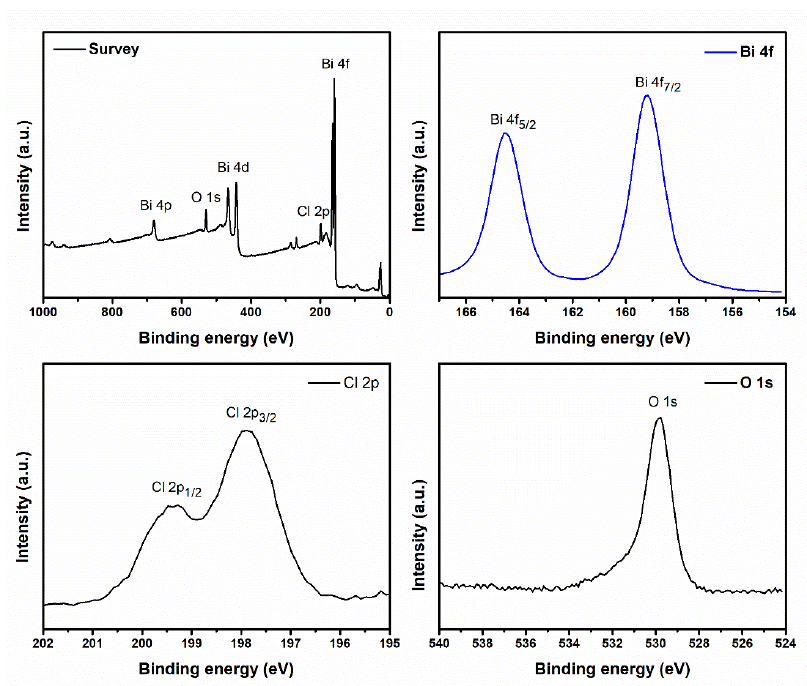
Figure 2. XPS spectra of BiOCl photocatalyst.